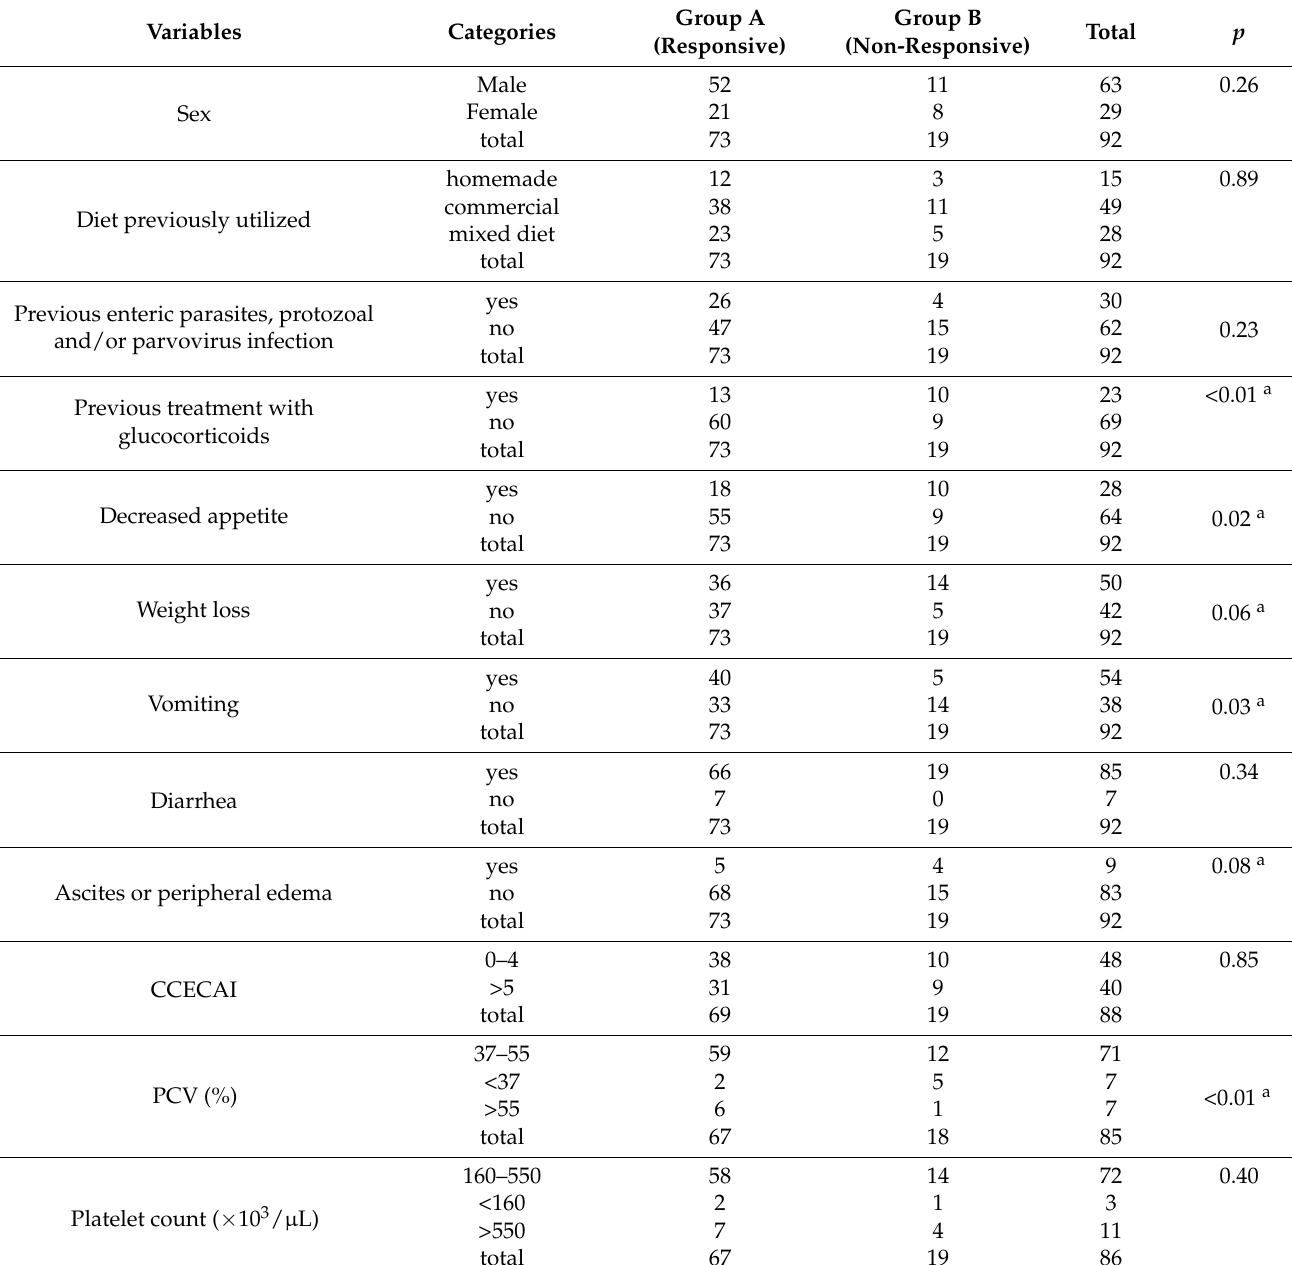
Table 2. Results of the univariate